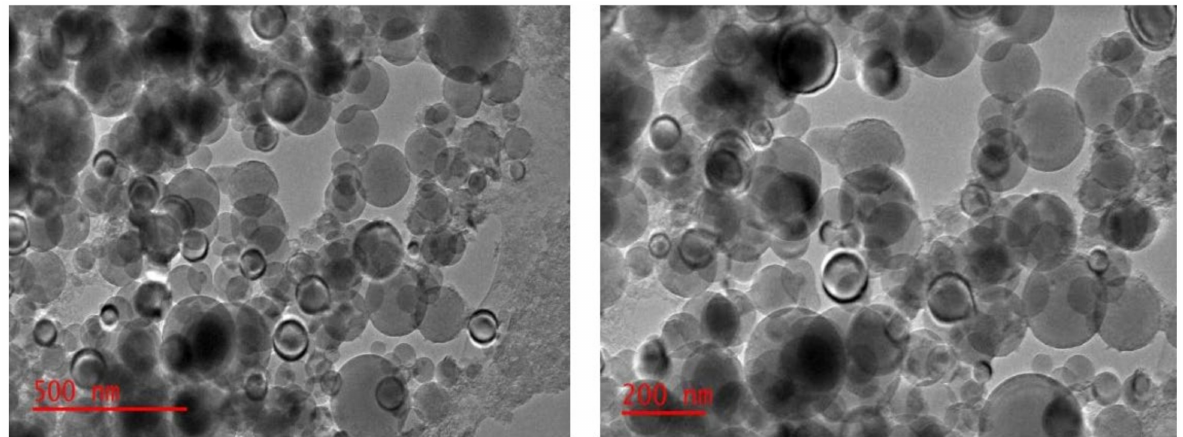
Figure 6. TEM images for nanocarbons carbonized at 400 ◦ C for 4 h. Adapted with permission from Ref.